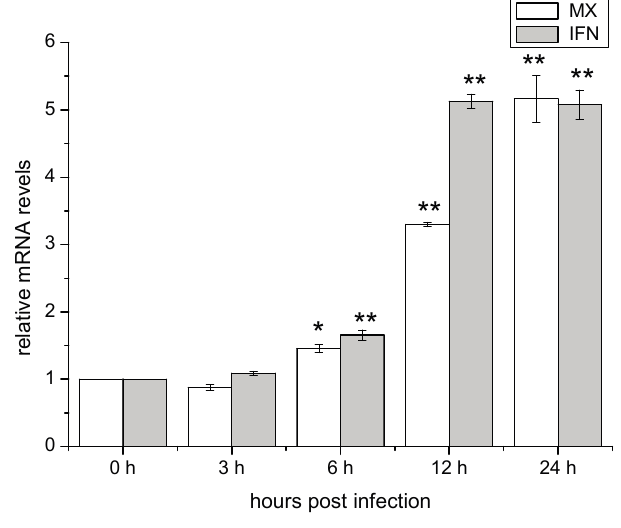
Figure 3. Expression of Mx and interferon ( IFN ) genes in ZF4 with time after SHVV infection. Expression was determined by qRT-PCR and β -actin was used as an internal control. Data were shown as mean ± SE ( n = 3). Fisher’s LSD test was